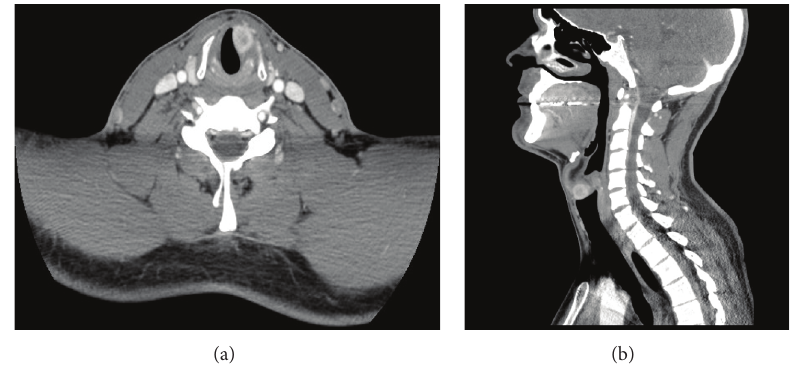
Figure 1: Axial (a) and sagittal (b) CT of the avidly enhancing mass in the anterior left vocal cord. vocal cords was noted and there was good glottis closure with pronation. The rest of the laryngeal exam was